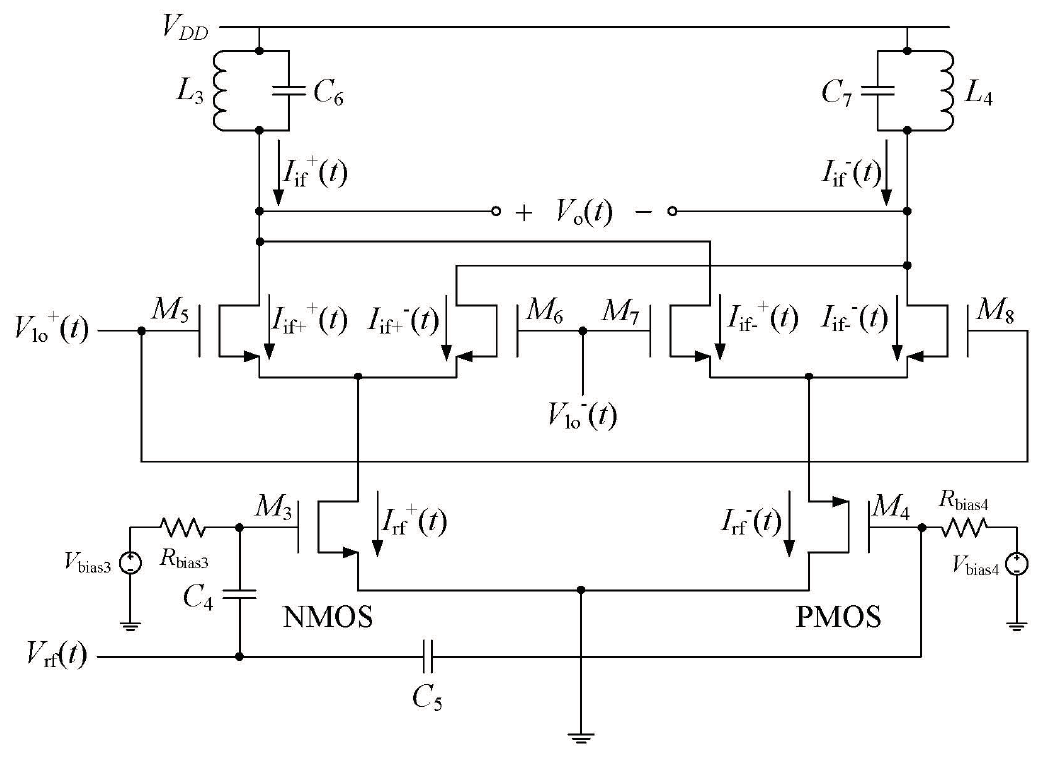
Figure 4. Schematic of the modified double balanced mixer.